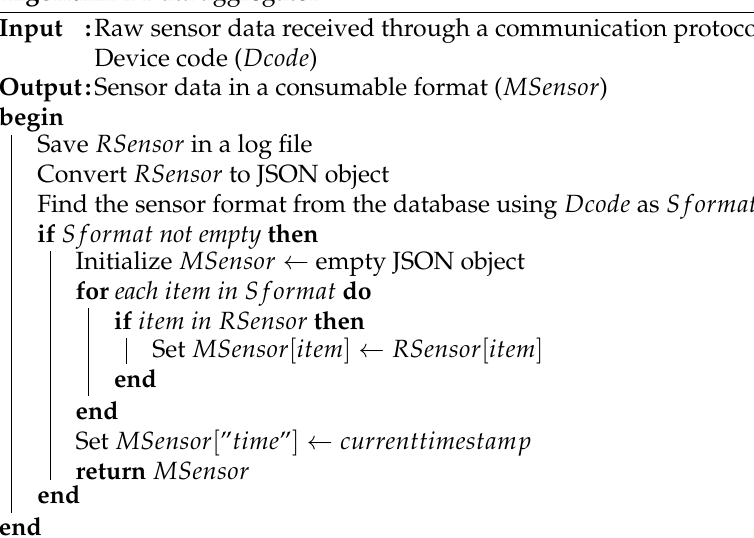
Algorithm 1 Data